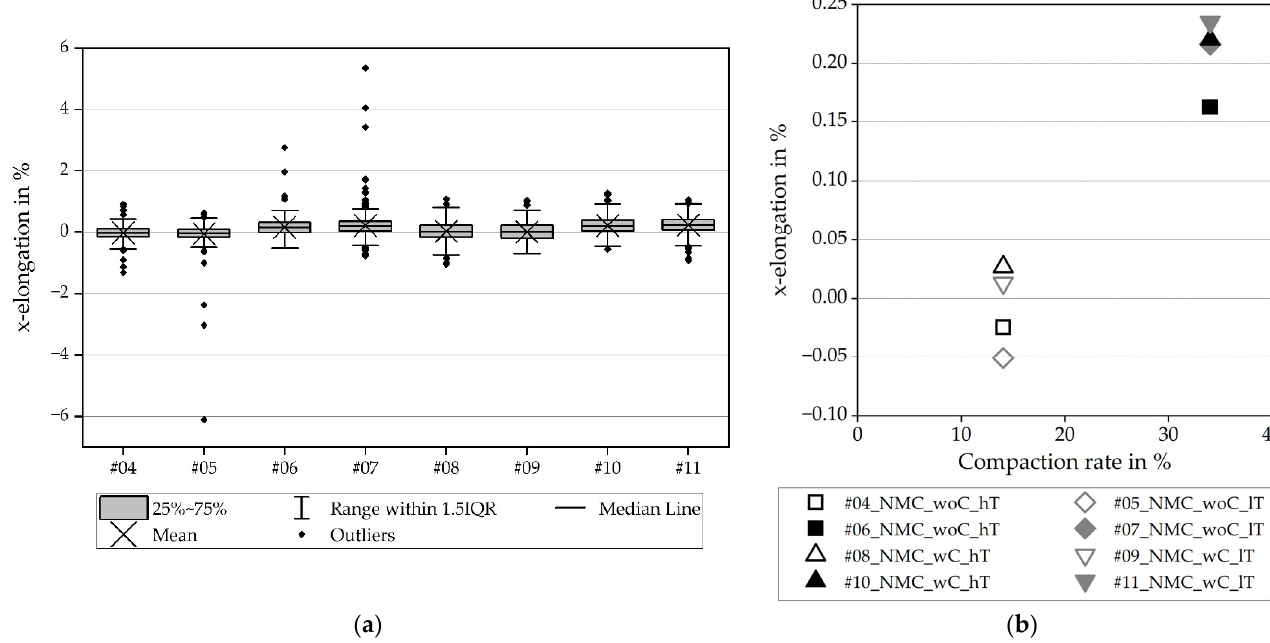
Figure 9. Elongation in the x-direction for NMC811: ( a ) all values including the scatter; ( b ) average values .